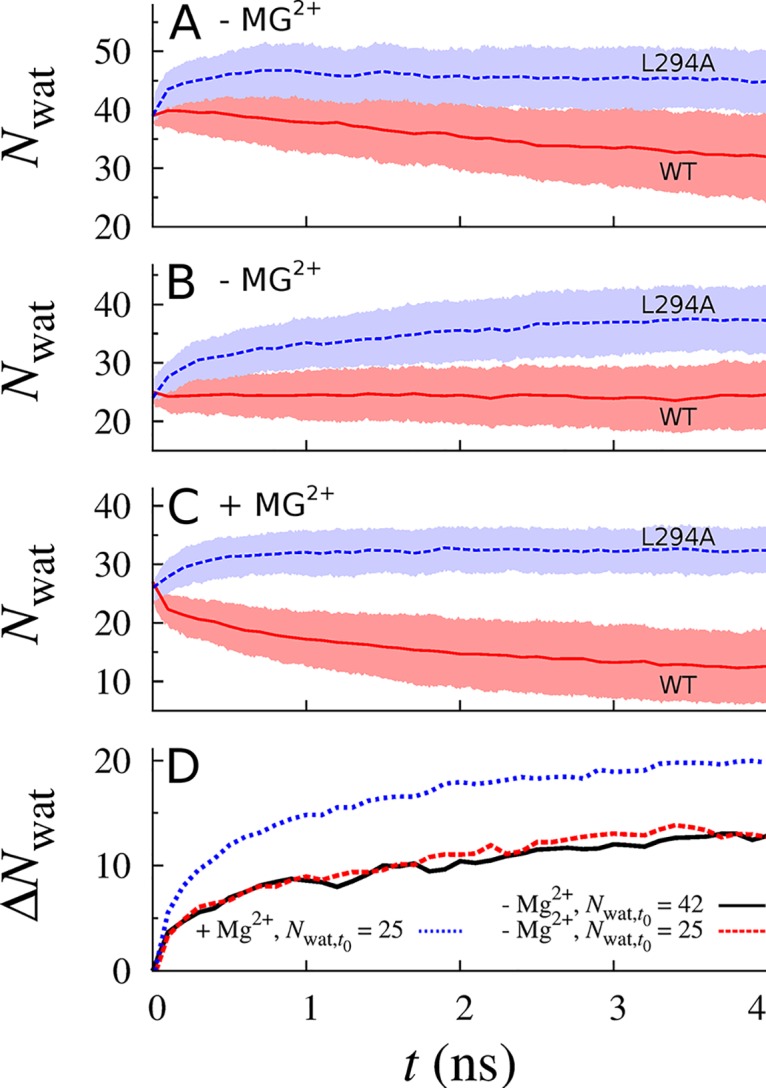
Enhanced MM wetting resulting from pore-widening mutation L294A.(A-C) Ensemble averages of the number of water molecules in the MM, N
wat, as functions of time, t, for (solid red) wild type, WT, and (broken blue) L294A simulations (A,B) without and (C) with regulatory ions in the DCS. Shaded regions enclose the standard deviation among 200 repeat simulations. Initial conformations had N
wat values of (A) 42 or (B, C) 25. (D) Increase in hydration due to the L294A mutation, ΔN
wat = N
wat(L294A)—N
wat(WT), as a function of t (black solid line) without regulatory ions, initial N
wat = 42; (red broken line) without regulatory ions, initial N
wat = 25; and (blue dotted line) with regulatory ions, initial N
wat = 25.